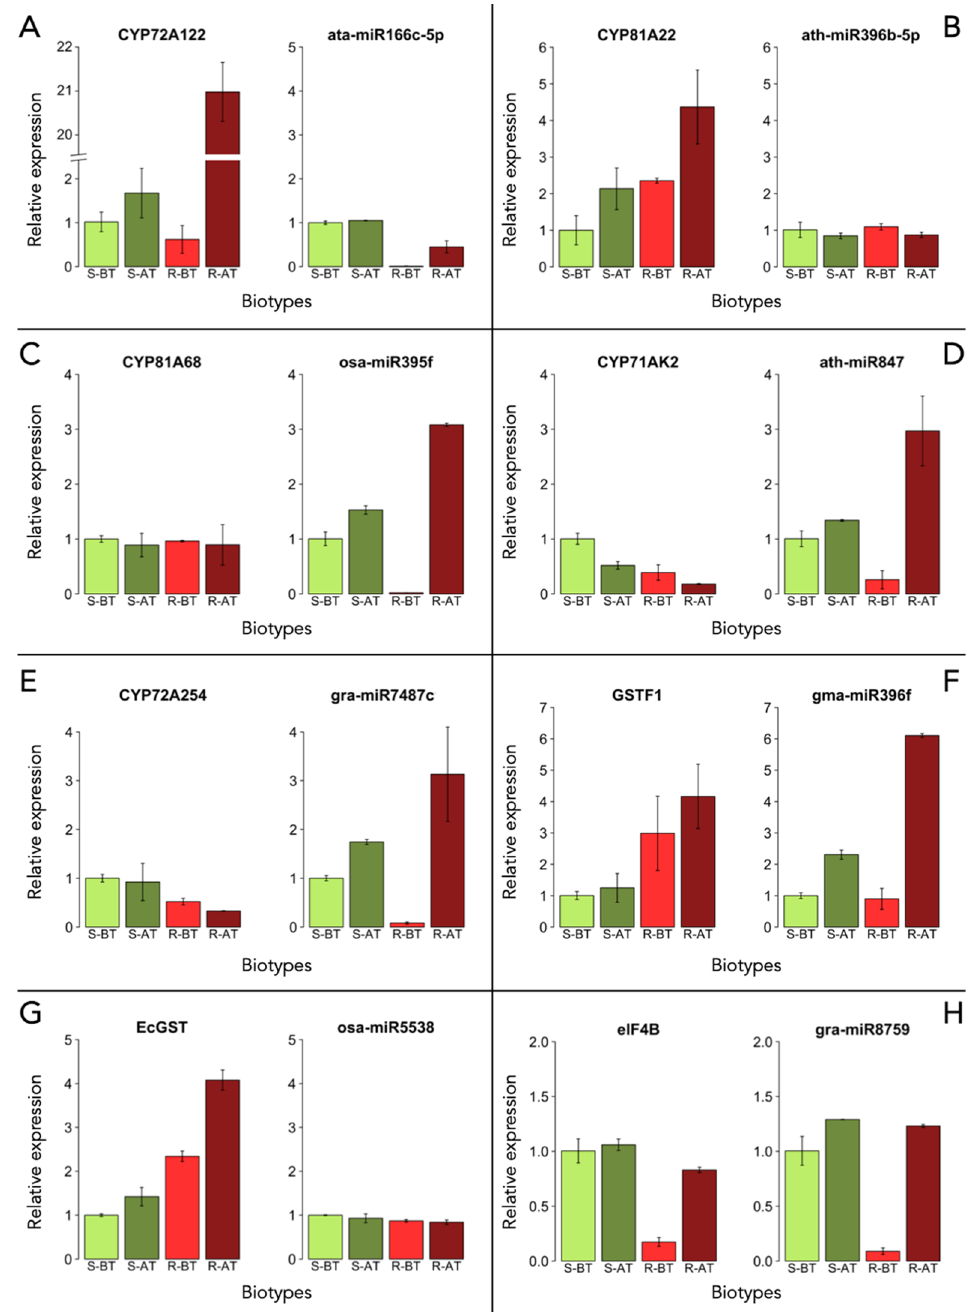
Figure 2. Expression levels of the miRNAs studied and the mRNA of their target genes in suscepti- ble (S) and resistant (R) specimens of Echinochloa crus-galli before (BT) and after (AT) bispyribac-sodium application. ( A ) CYP72A122 and ata-miR166c-5p; ( B ) CYP81A22 and ath-miR396b-5p; ( C ) CYP81A68 and osa-miR395f; ( D ) CYP71AK2 and ath-miR847; ( E ) CYP72A254 and gra-miR7487c; ( F ) GSTF1 and gma-miR396f; ( G ) EcGST and osa-miR5538; ( H ) eIF4B and gra-miR8759. Error bars indicate the standard deviation of three replicates.